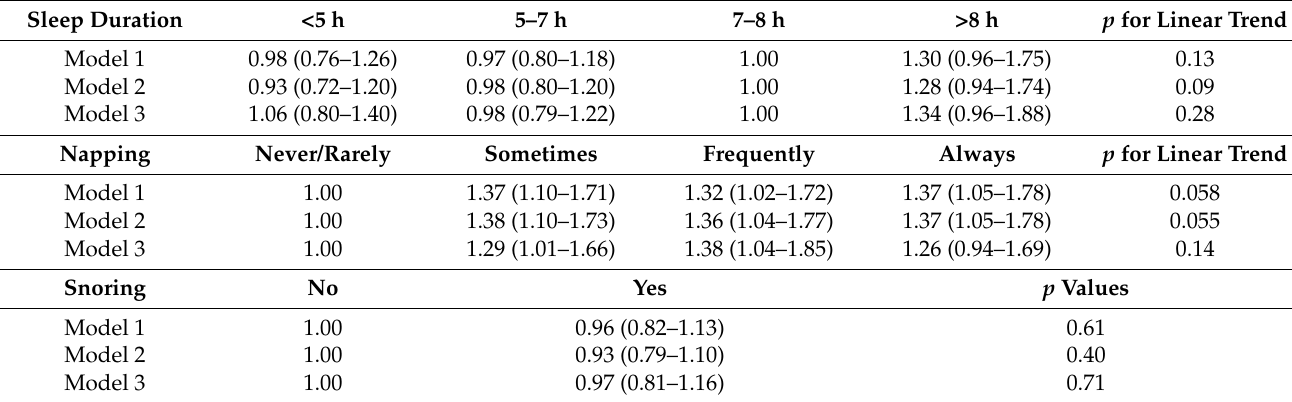
Table 2. Association (OR 95% CI) between sleep characteristic and poor glycemic control among people with diabetes. Sleep